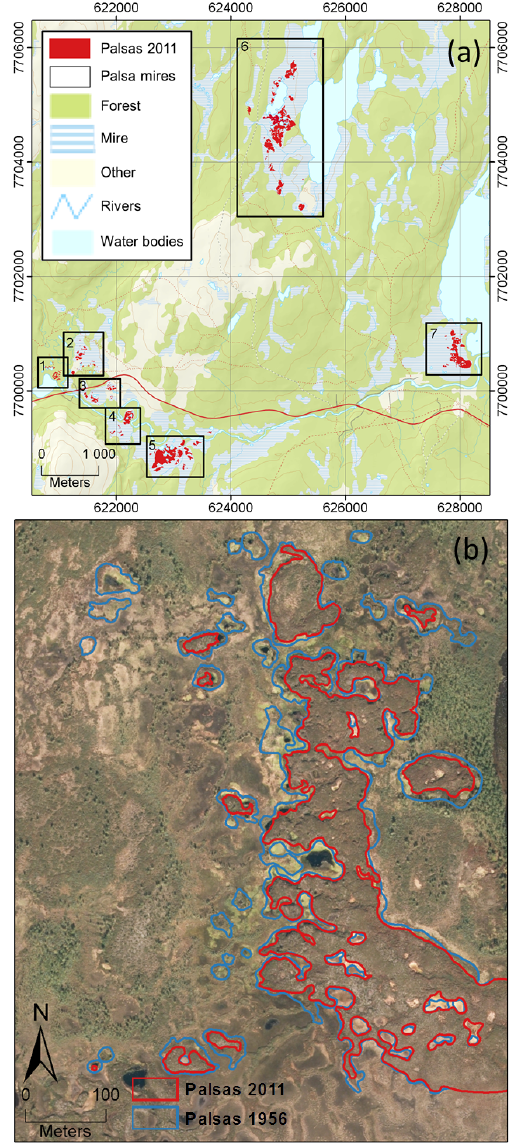
Figure 8. (a) Palsa mires mapped in the study area Suossjavri. Background map from Kartverket (2015b) with projection in UTM 34N. (b) Palsas and peat plateaus mapped in palsa mire 7 in Suossjavri. To increase the visibility of this figure, only the delin- eation of palsas from 1956 and 2011 is included. Background image from 2011 through Norgeibilder (2015).